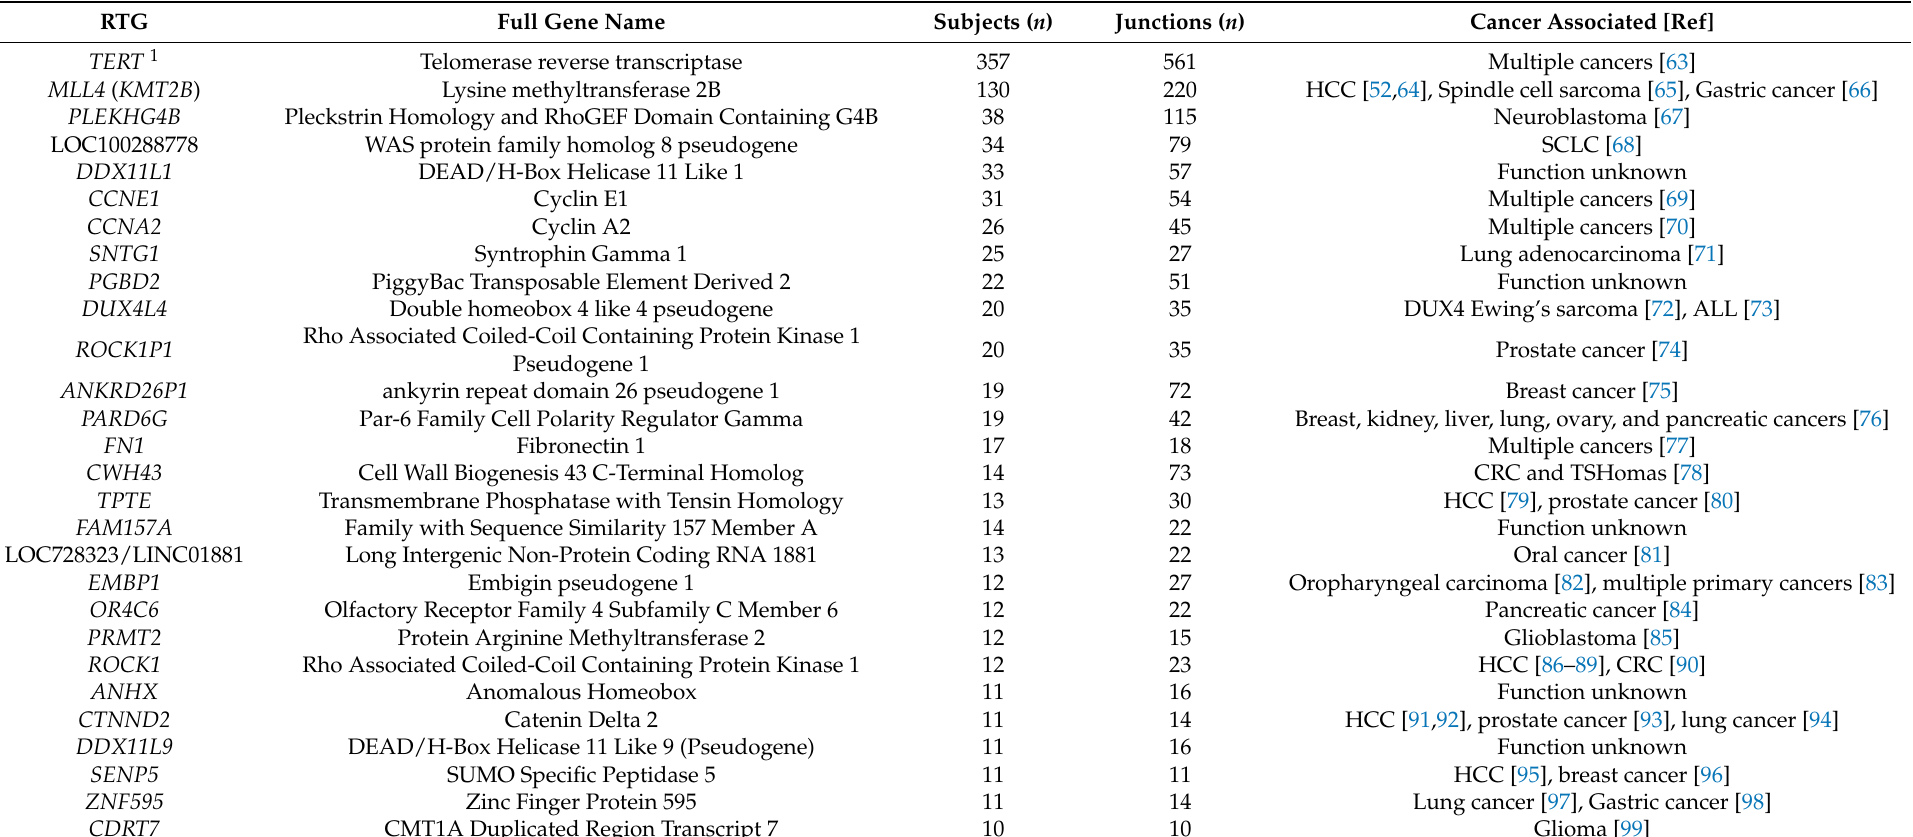
Table 3. Most frequently reported genes with HBV integrants in HCC